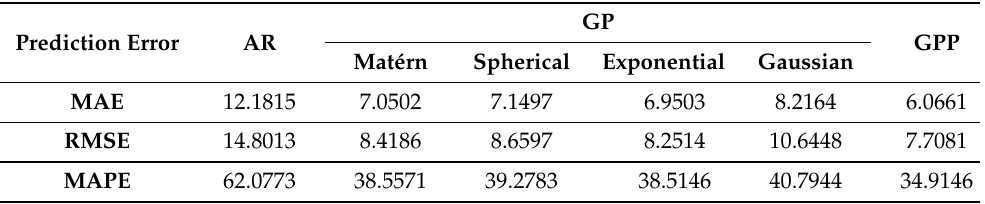
Table 3. Spatial prediction error of GP, AR and GPP models.